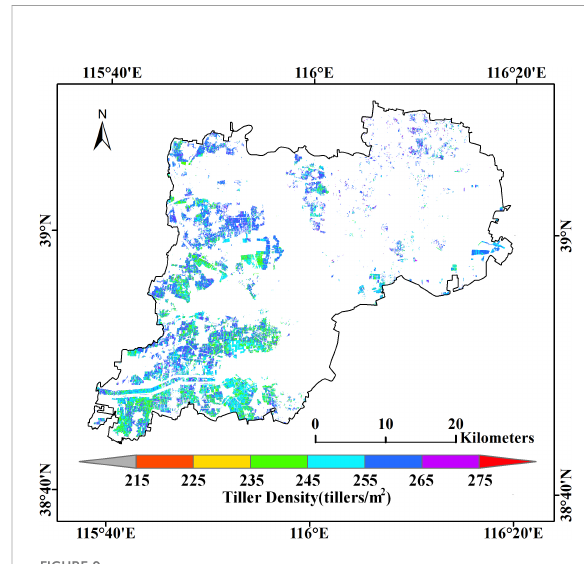
FIGURE 9 Estimated values of the tiller density obtained by extending the RF model to the Xiongan winter wheat crop area.